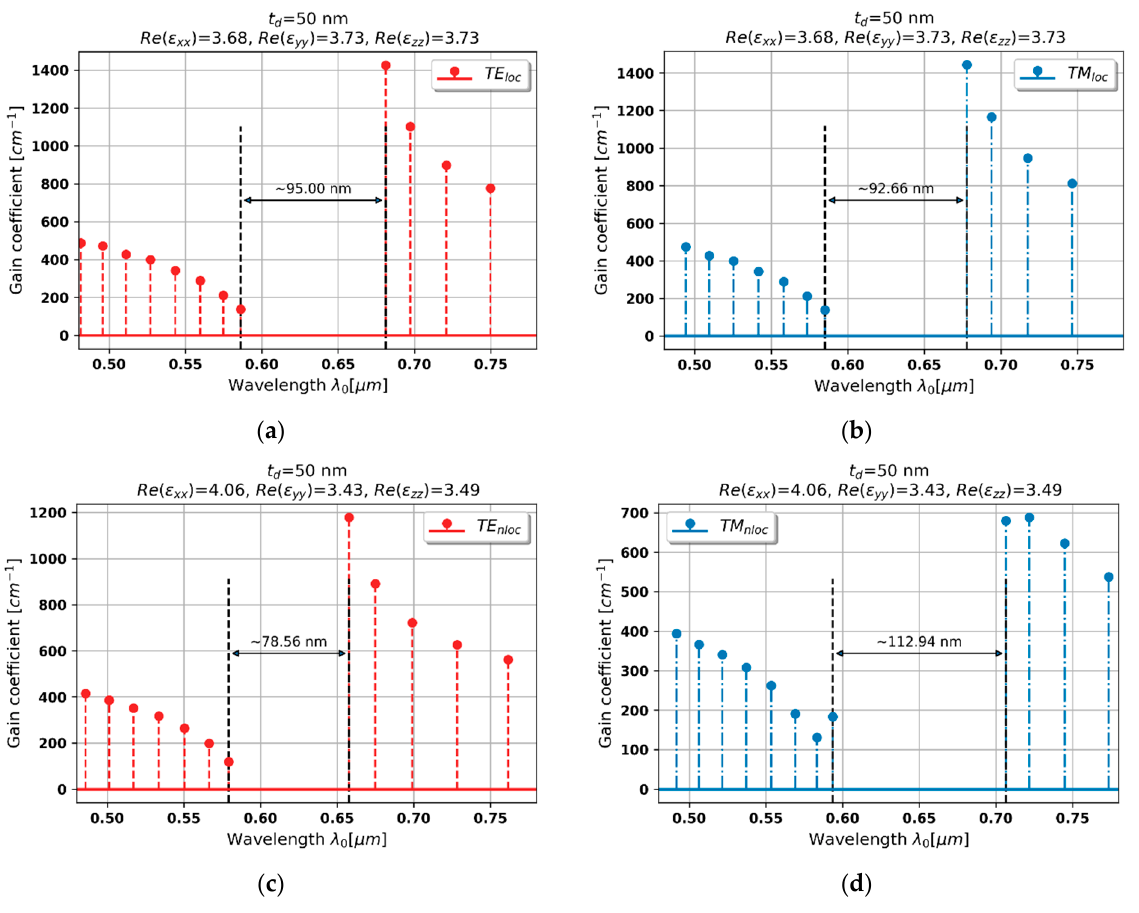
Figure 5. Modal spectra for TE ( a , c ) and TM-polarized light ( b , d ) for a PHC laser based on hyperbolic medium with t ZnO = 50 nm dielectric layer (black double-headed arrow denotes spectral width of stop band of the spectrum).